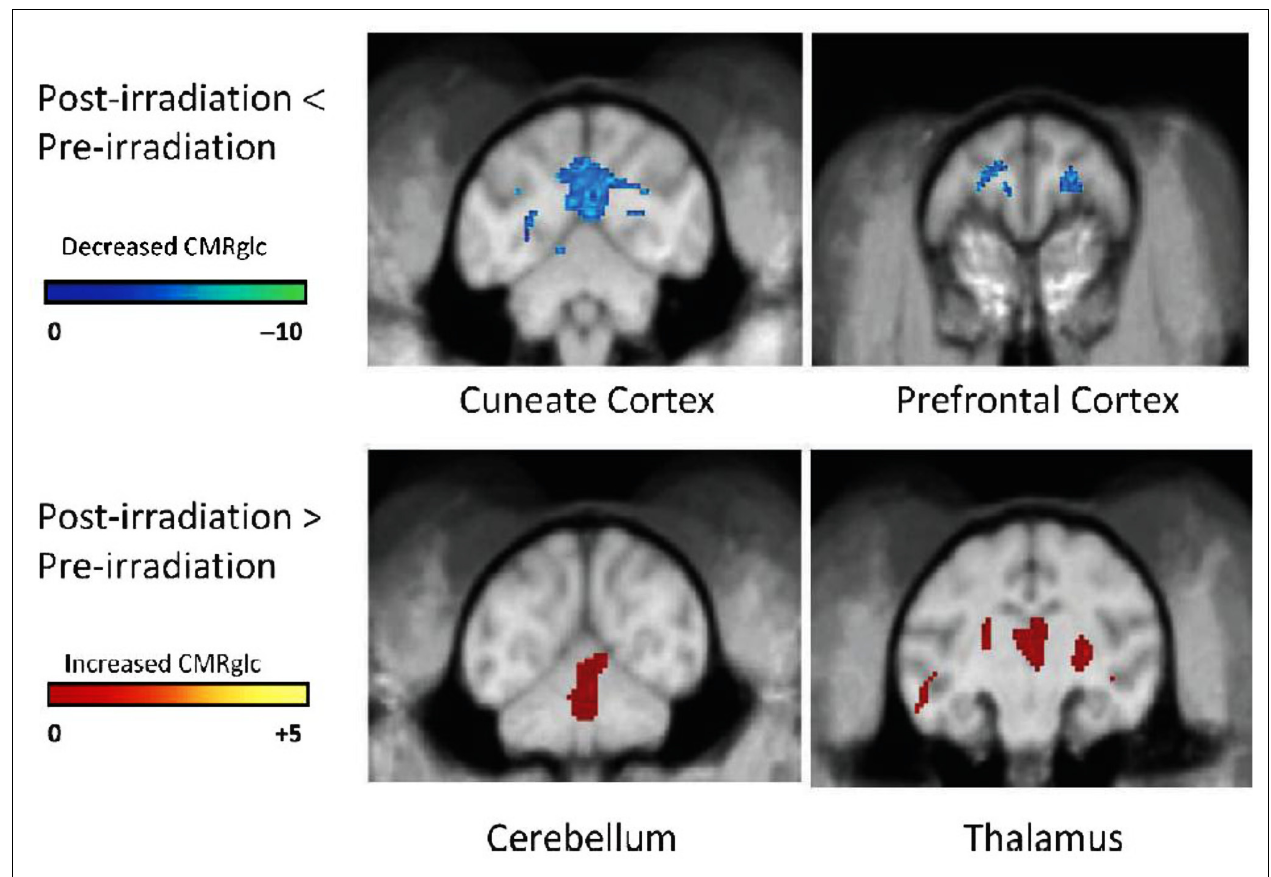
post-fWBI > Pre-fWBI: the red areas in the cerebellum and thalamus exhibited greater metabolic activity in scans obtained 9 months after fWBI than in scans obtained prior to fWBI.The color bar is the degree of intensity difference shown as a scale of t values with P < 0.001. Adapted from Robbins etal.